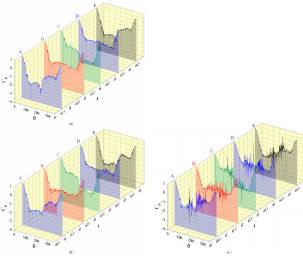
Figure 8. Pressure distributions for particular time instants of the flow past a circular cylinder (Re = 1.0 × 10 5 ): ( a ) Smooth; ( b ) ε = 0.10%; ( c ) ε =